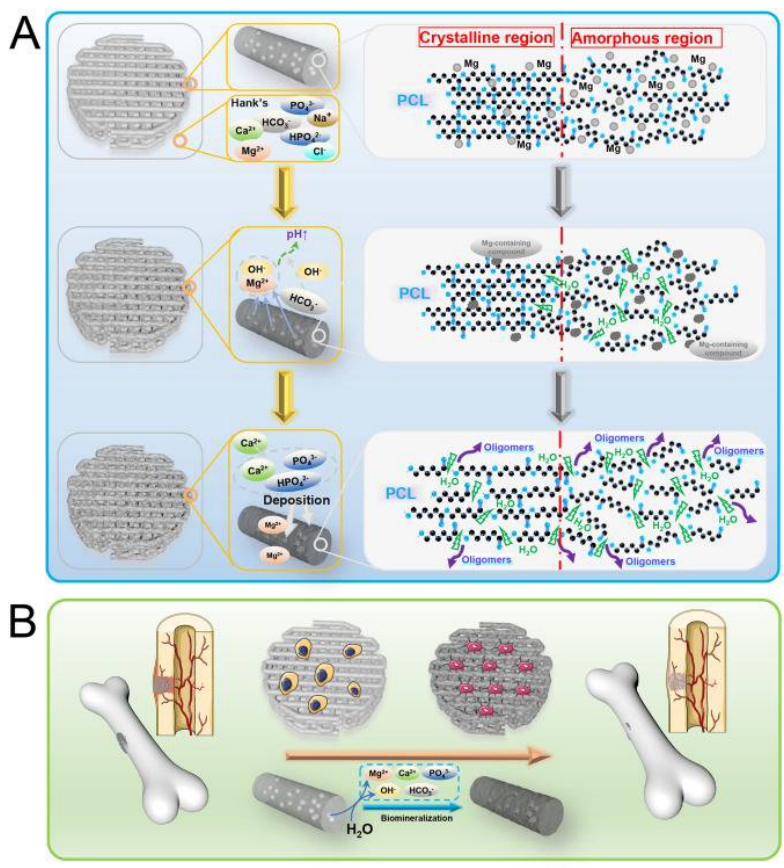
Figure 3. Reactions of Mg/PCL scaffolds for bone healing in vitro and in vivo, showing ( A ) degrada- tion behavior and ( B ) biological activity [53].